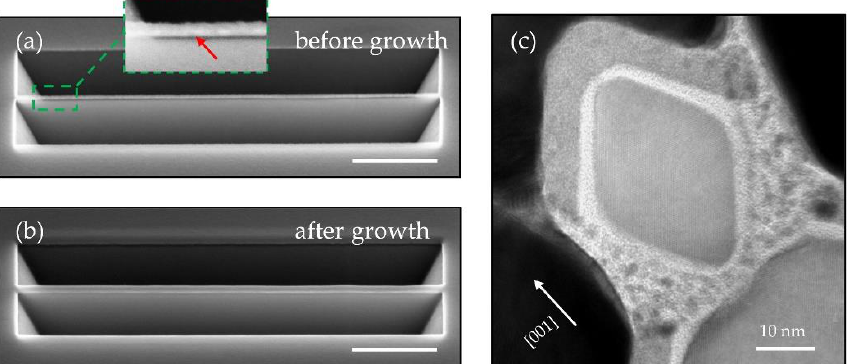
Figure 5. Suspended Si NW before ( a ) and after epitaxy ( b ). They both have a straight structure without distortion. Scale bar: 400 nm. ( c ) Cross-sectional HRTEM showing the high-quality diamond with four {111} facets after epitaxy. The red arrow in the inset of ( a ) highlights the suspended structure.